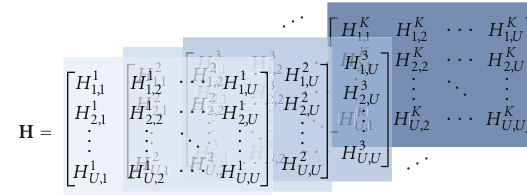
Figure 4: MIMO channel matrix H with dimension U × U × K , where U is the number of lines in the cable binder and K is the number of subchannels in a MIMO